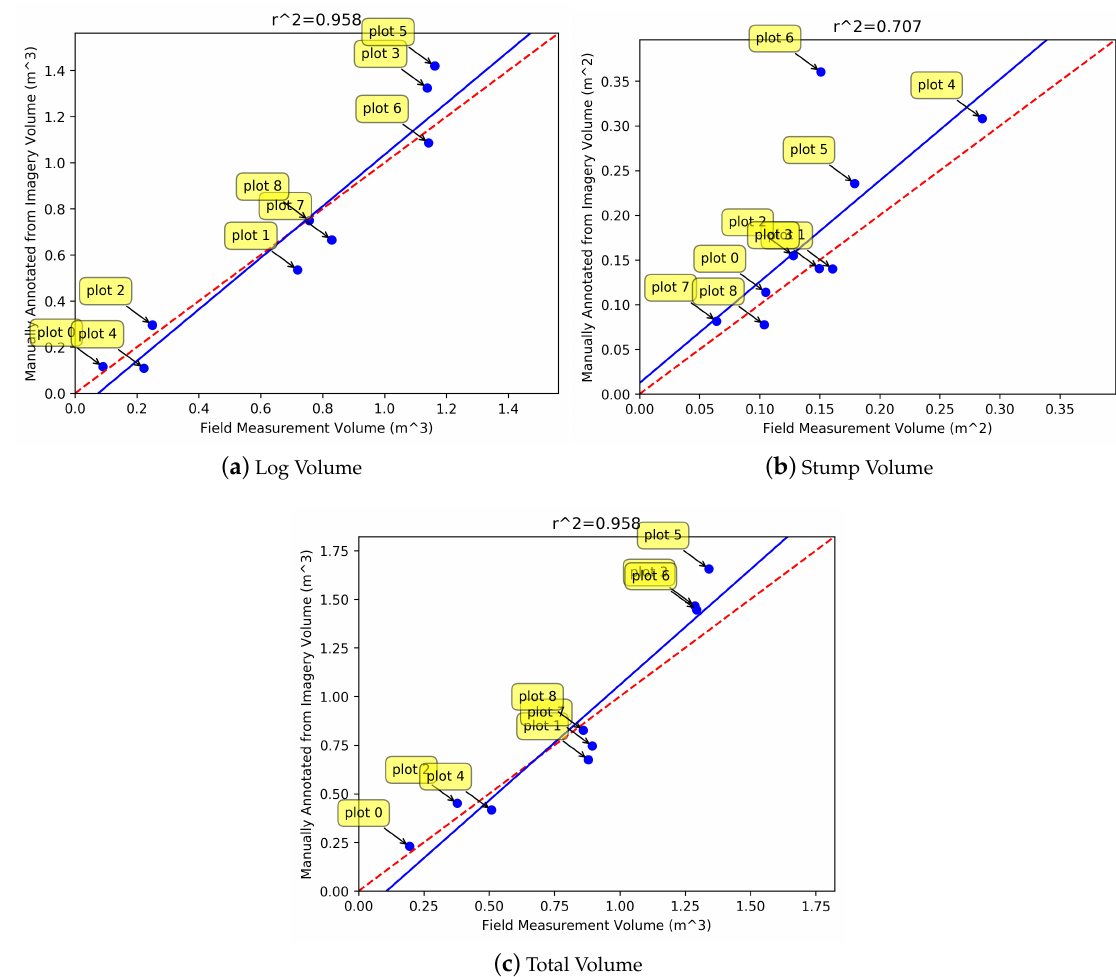
Figure 8. Comparison of volume calculated from digital image annotations vs. in situ (field) measured total plot log volume for ( a ) logs/CWD (excluding stumps), ( b ) stumps and ( c ) total stump/log volume across nine plots. Blue line indicates a linear regression between the data points and red dotted line shows a unit-slope line representing a perfect one-to-one relationship for